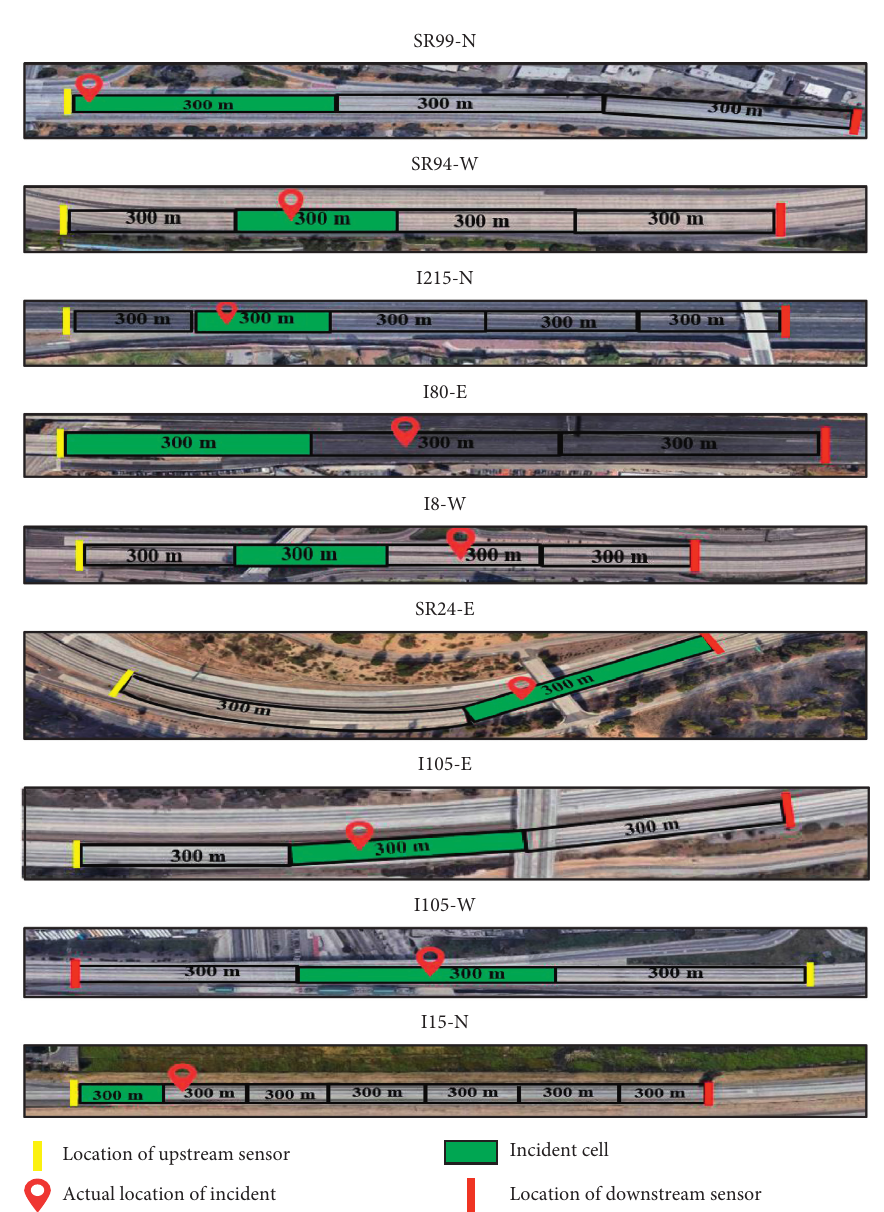
Figure 10: Comparison of the estimated and actual incident